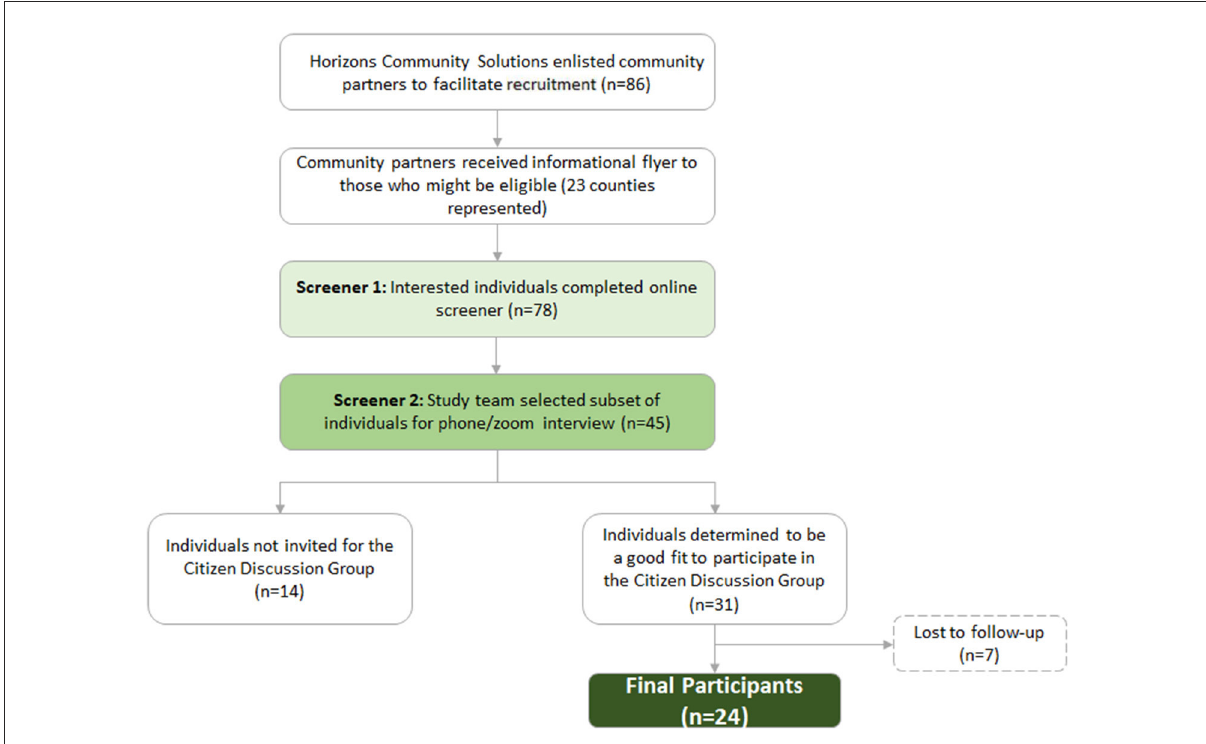
FIGURE2 Recruitment flow